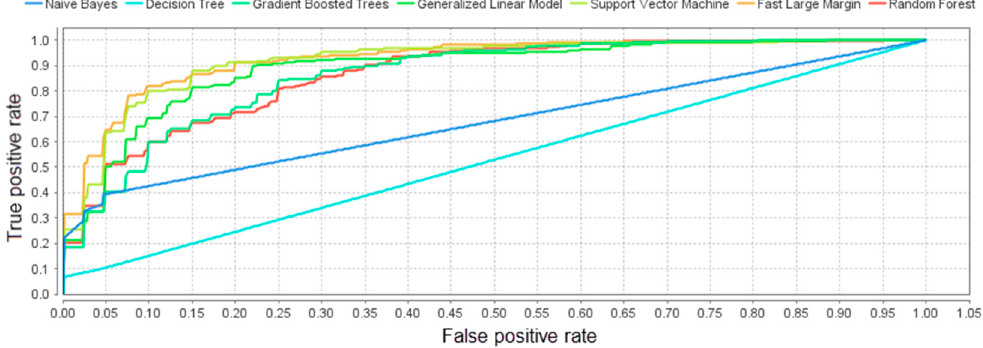
Figure 2. ROC (receiver operating characteristic) curves of different classification methods, used for initial email message classification to spam and phishing.